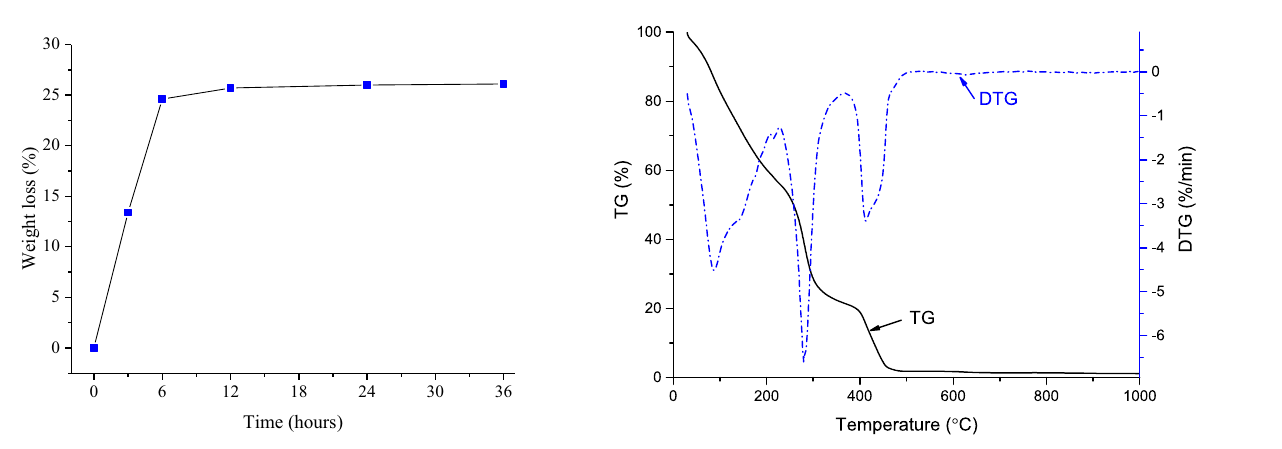
Fig. 7 Weight loss curve of frozen specimen during freeze-drying Fig. 8 TG and DTG curves of a freeze-dried